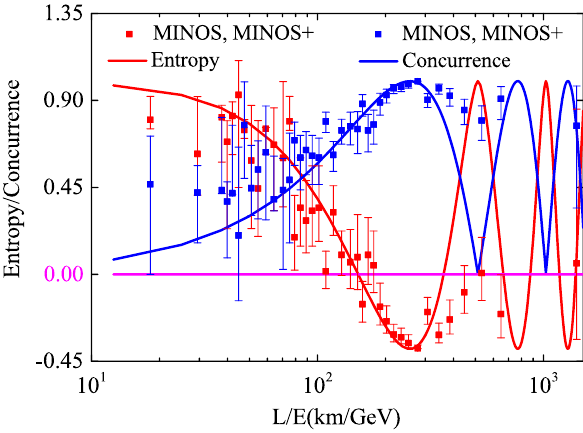
Fig. 3 Experimental results for the entanglement witness with respect to the ratio L / E for the initial muon flavor state. The entropy (solid line, red) S ( P | B ) + S ( R | B ) + log 2 c ( P , R ) , and the concurrence (solid line, blue) of neutrino-flavor state in theory and experiment with the error bars. The magenta solid line denotes the entropy limit (zero